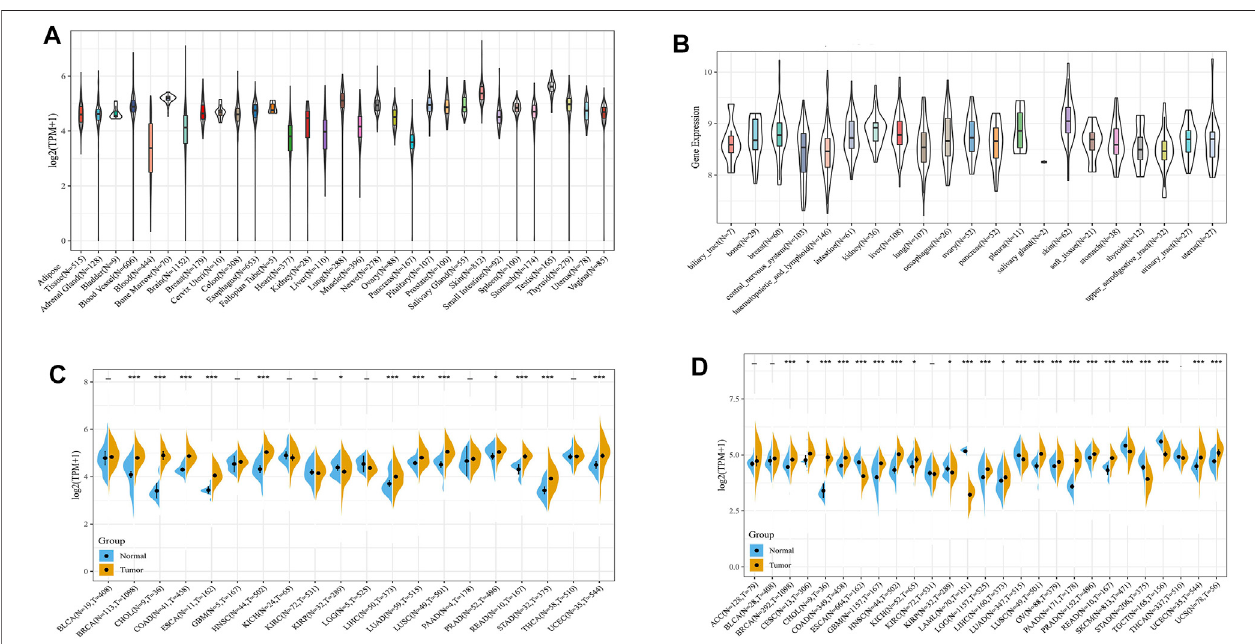
FIGURE 1 | The expression level of ATG101 in different cancer patients. (A) The expression of ATG101 in 31 normal tissues from the GTEx database. (B) The expression ofATG101 in21types ofmalignant cancercellsfrom theCCLE database. (C) Theexpression ofATG101between20types ofmalignant tumourtissuesand normaltissuesfromtheTCGAdatabase. (D) TheexpressionofATG101in27typesofmalignanttumourtissuesfromtheTCGAdatabaseandthecorrespondingnormal tissues from the GTEx database. * p < 0.05, ** p < 0.01, *** p <